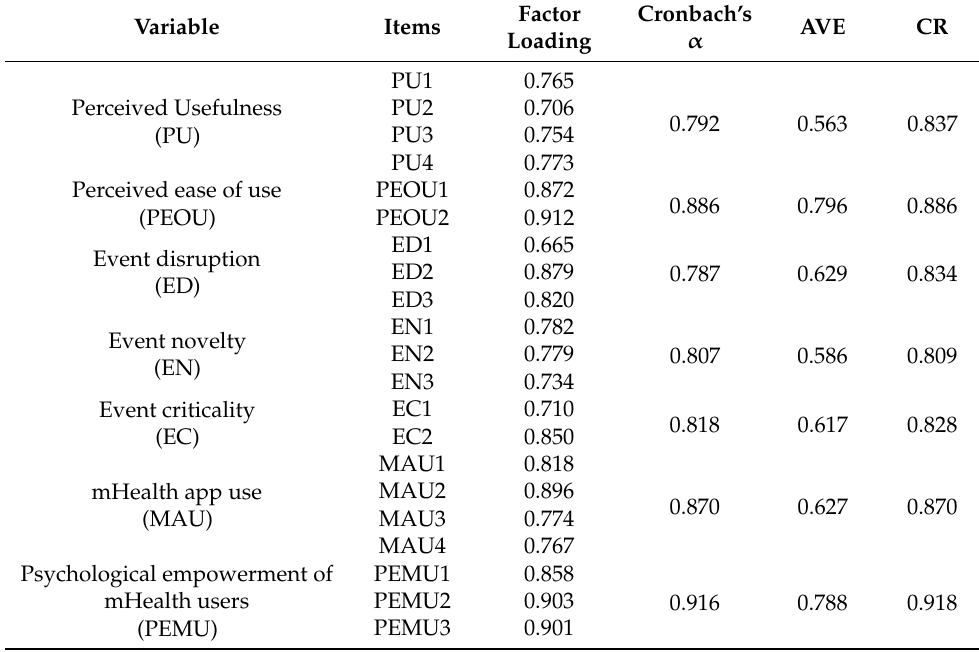
Table 2. Reliability and Convergent Validity Test